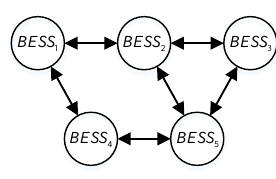
Figure 6. Node of BESSs.